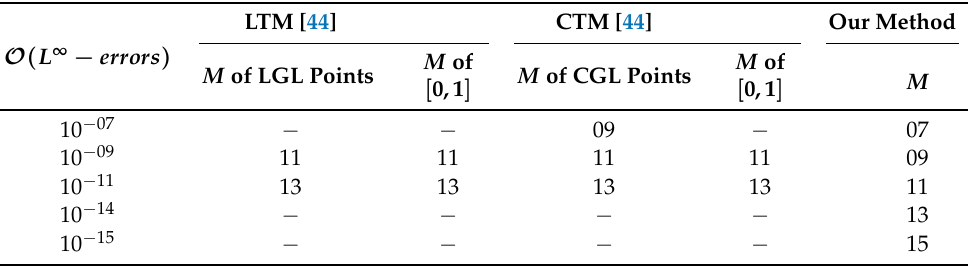
Table 6. Comparison of L ∞ -errors of our algorithm for υ 1 = 0.5 and b = 0 with the Tau method in [44] by the approximate solution of degree M for Example